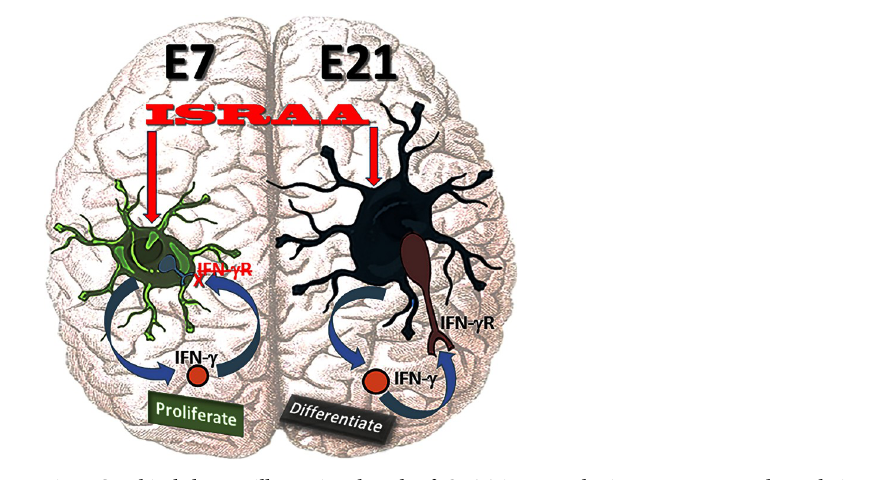
Fig 1. Graphical abstract illustrating the role of ISRAA in mouse brain astrocytes growth regulation through the cytokine network involving IFN- γ . ISRAA acted on embryonic brain astrocytes early at E7 and late at E21. It stimulated them to produce IFN- γ . E7 astrocytes did not express IFN- γ R; therefore, they could not respond to the anti- proliferative effects of IFN- γ and continued to proliferate. However, E21 cells did express IFN- γ R, and, accordingly, they ceased proliferation and began to differentiate.